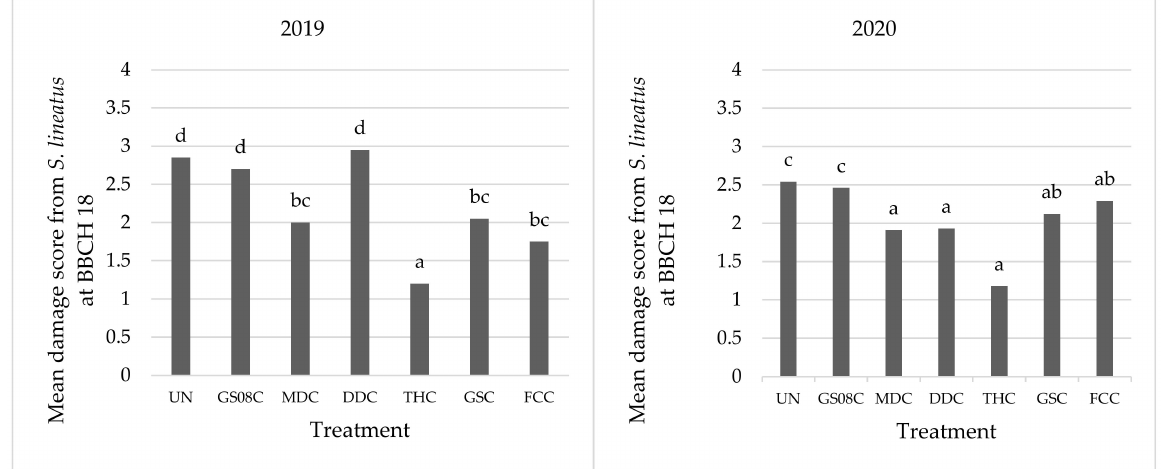
Figure 3. Effect of spray regime on Sitona lineatus feeding (mean damage rating) on broad bean at BBCH18 in 2019 and 2020. Note: Different letters in column indicate significant difference between treatments ( p < 0.05); ( p -value ≤ 0.0001 for 2019, p -value = 0.0231 for 2020). UN, untreated control; GS08, at BBCH 08 growth stage; MDC, when first pea leaf weevil adult was caught in yellow water trap; DDC, when daily air temperature for three days exceeded that of threshold for adult activity; THC, at local threshold (5–10 weevils m − 2 ); GSC, at BBCH 10–11 growth stage; FCC, full control spray at BBCH 10, 30, and 69 growth stages. Rating scales of leaf damage: (0 = no notches; 1 = 1–10% of leaf margin with damage; 2 = 11–50%; 3 = 51–75%; 4 =